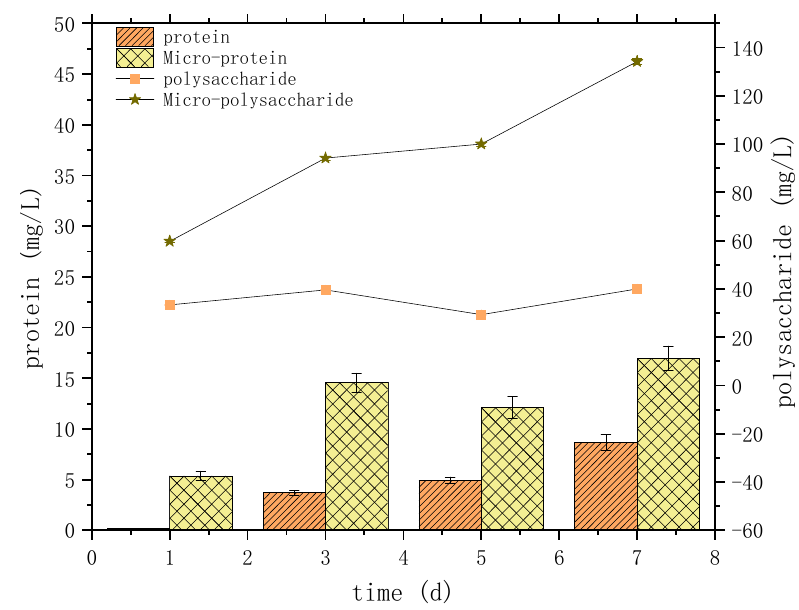
Figure 5. Effect of reaction time on protein and polysaccharide concentration. Figure 6 shows the change characteristics of the components of fluorescent substances at different times. With the increase in time under microaerobic conditions, the peaks in region IV moved to the positive direction of the abscissa, and their fluorescence intensity was higher than that of the control phase, indicating that the metabolic activity of microorganisms was higher under microaerobic conditions. The fluorescence intensity of amino acid protein and tyrosine protein showed an increasing trend and decreasing trend, and a relatively low fluorescence intensity appeared on day 3, indicating that the protein may be converted into NH 4+ -N under the action of microorganisms, which is consistent with the phenomenon in Figure 2.